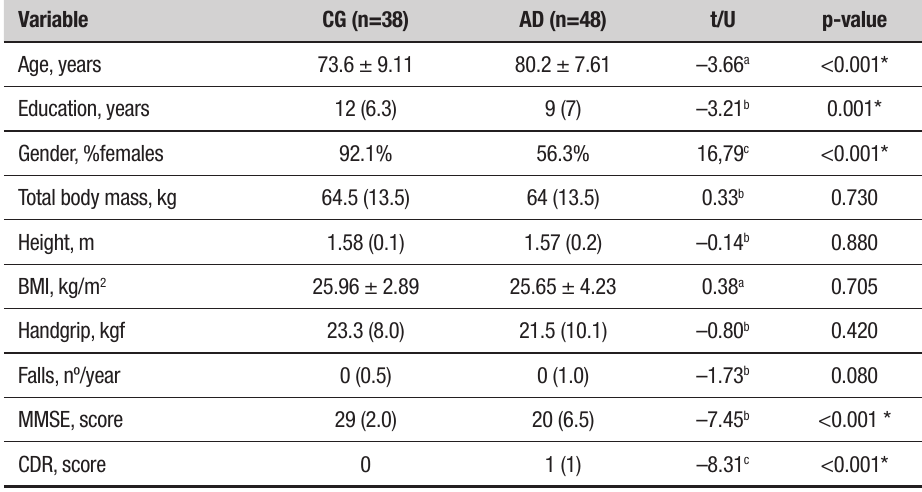
Table 2. Descriptive analyses of